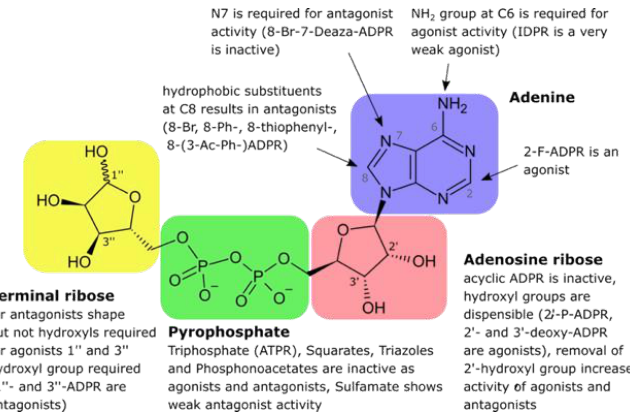
Figure 5. Structure – activity relationship of ADPR. Figure 5. Structure–activity relationship of